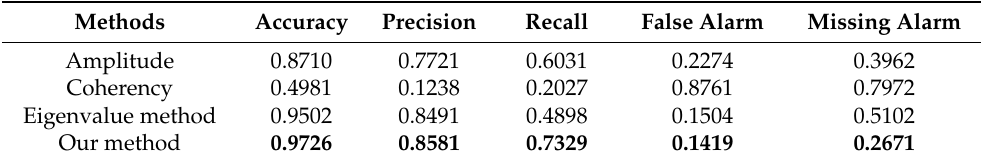
Table 2. Evaluation of traditional methods and our method on the test dataset.